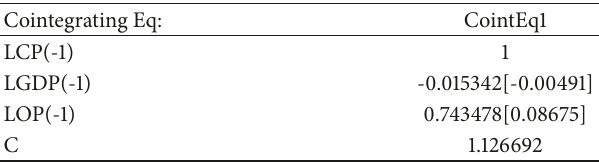
Table 6: Results of cointegration